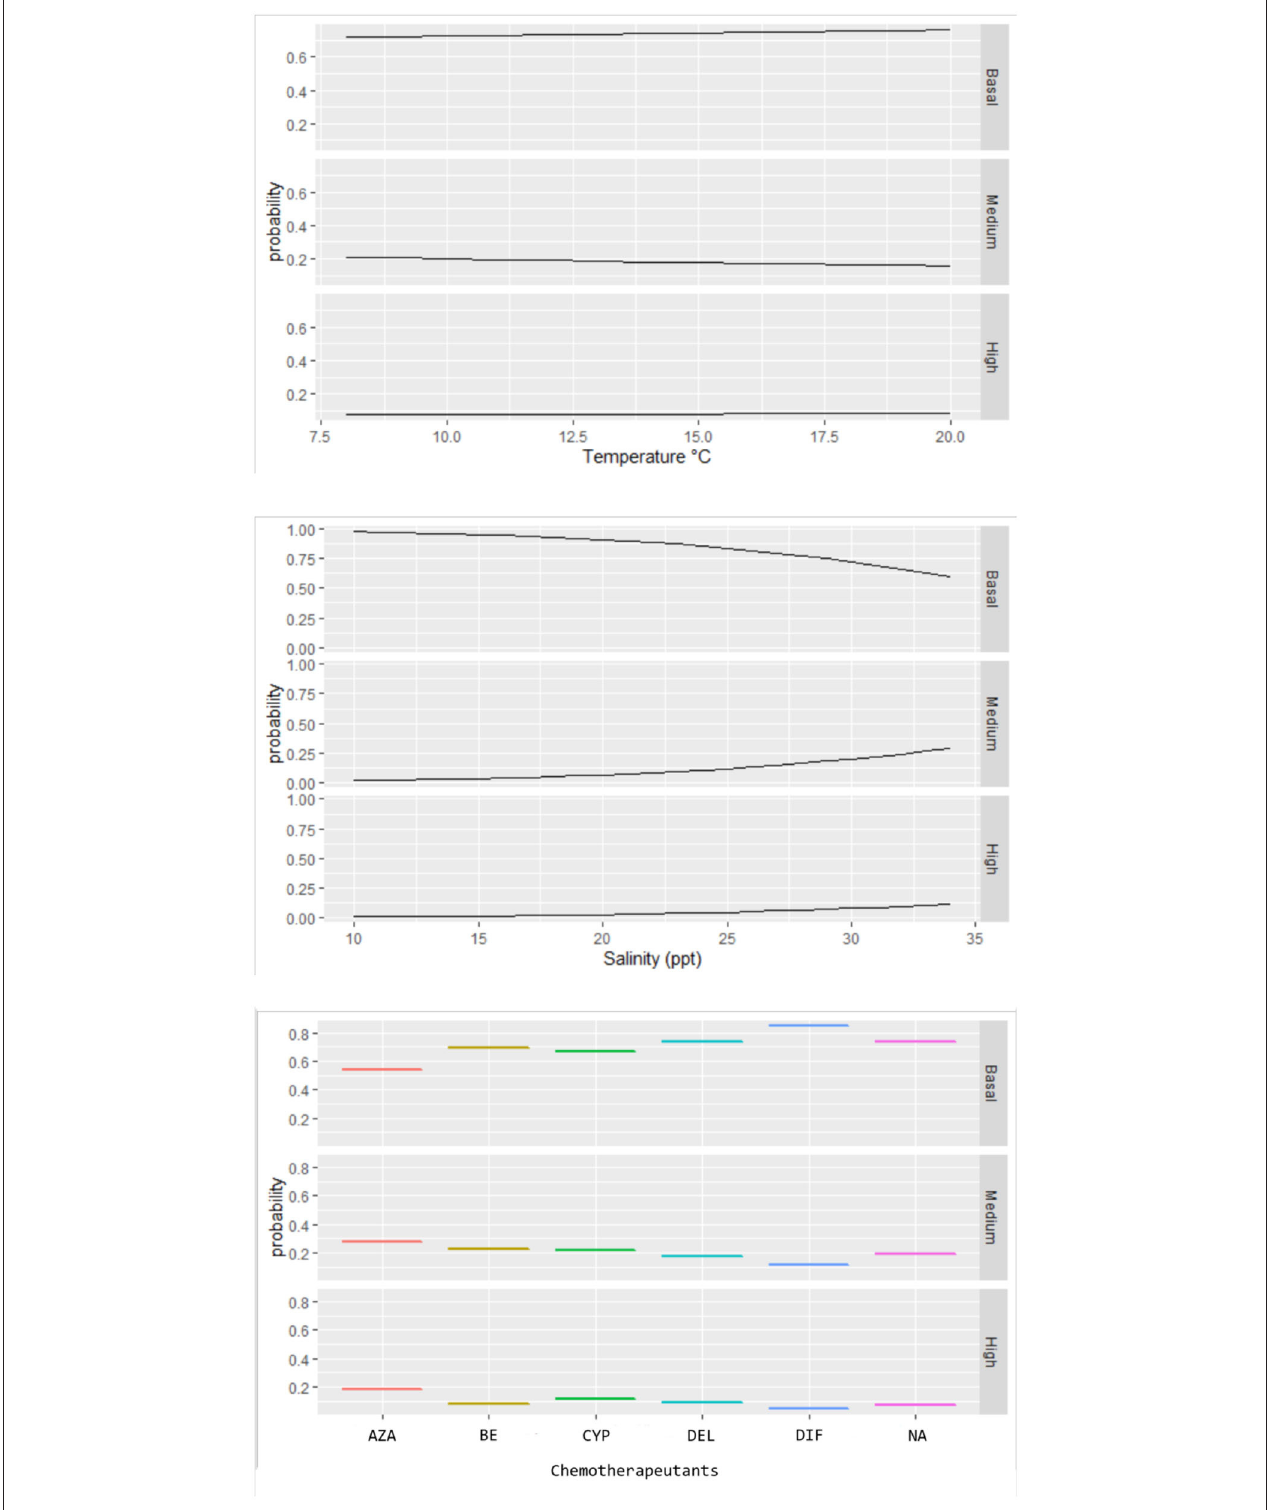
Figure 4 | Probability values estimated by the multinomial model for the effects of associated factors to infestation category of C. rogercresseyi (basal, medium, and high) in southern Chile during 2012–2016. The final multinomial regression model included year category, salmon species, latitude in decimal degrees, average weight, temperature, salinity, and chemotherapeutants. *Chemotherapeutants: azamethiphos, emamectin benzoate, cypermethrin, deltamethrin, diflubenzuron, and no treatment.